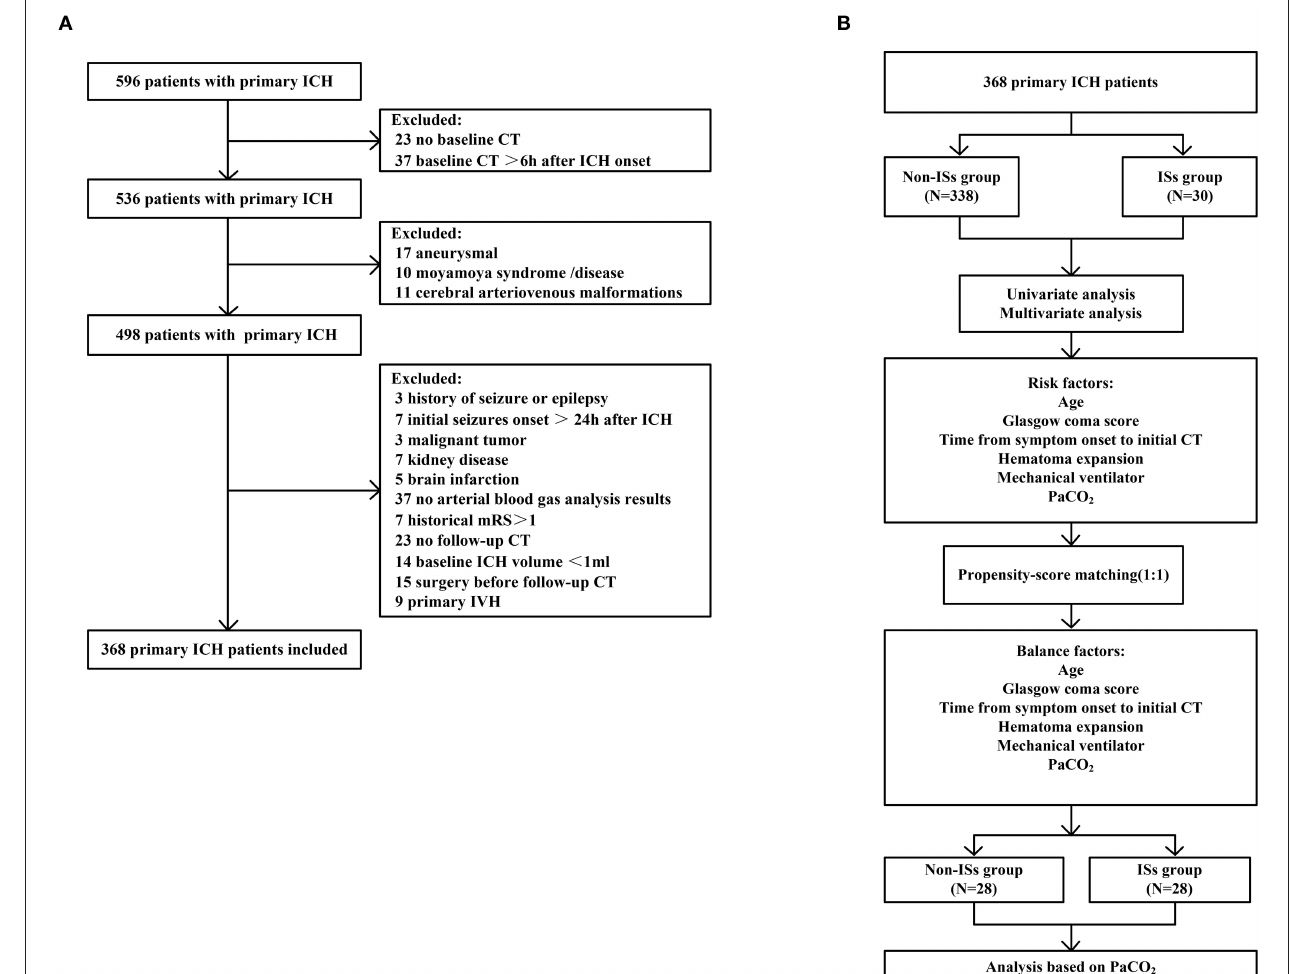
FIGURE 1 | Flow diagram of the patient selection process. (A) Flowchart of patient inclusion; (B) Flowchart of propensity-score matching. ICH, intracerebral hemorrhage; IVH, intraventricular